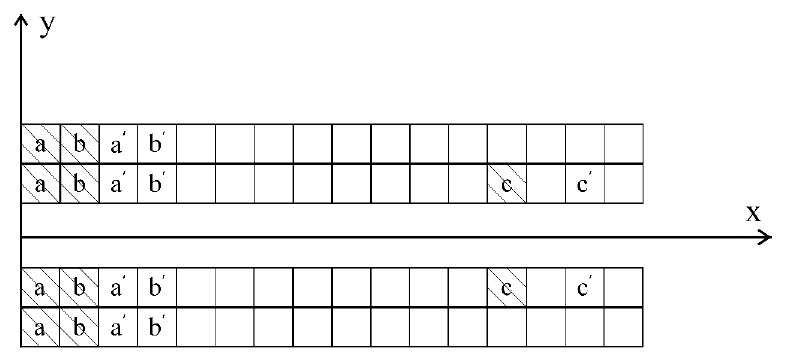
Figure 6. Moving load random loading process.